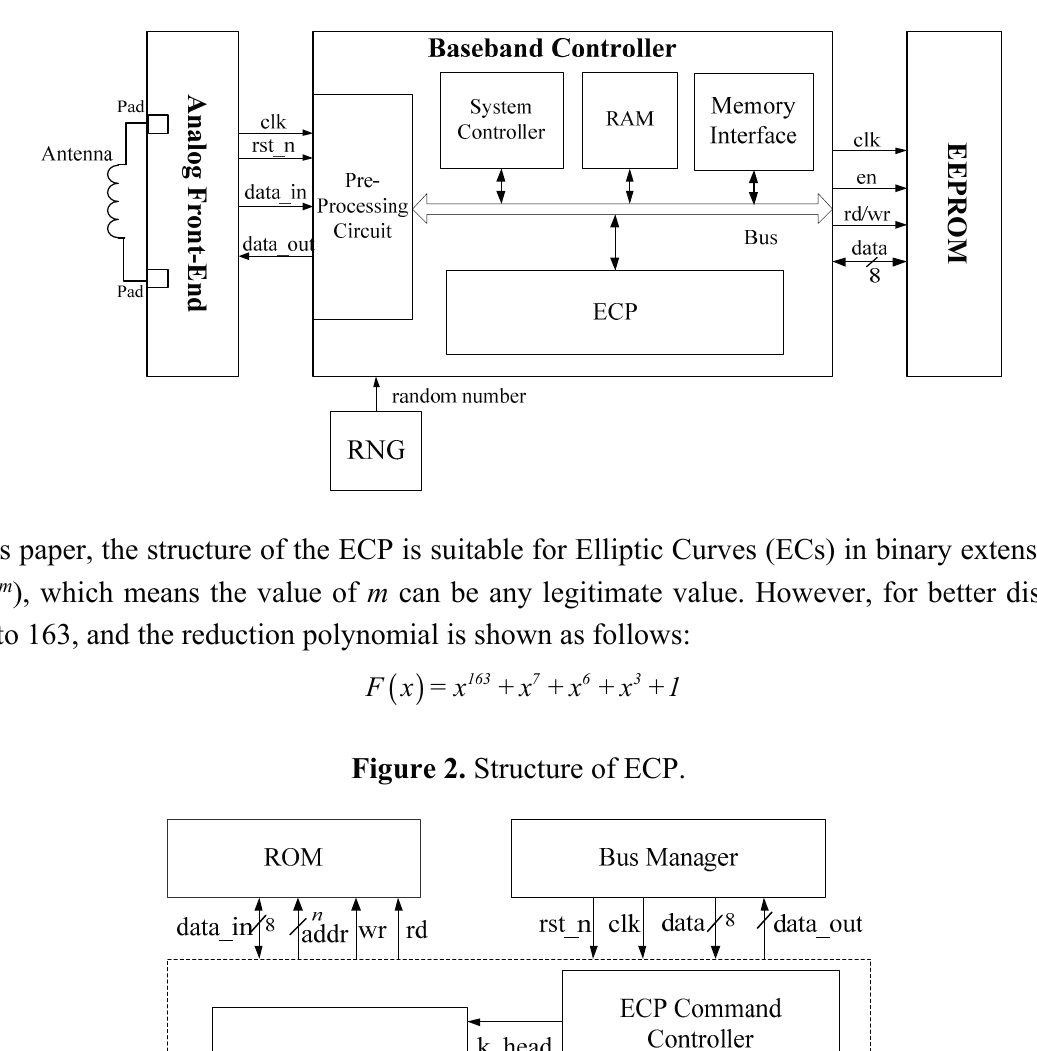
Figure 1. The structure of Radio Frequency Identification (RFID) tag with an Elliptic Curve Cryptography Processor (ECP).